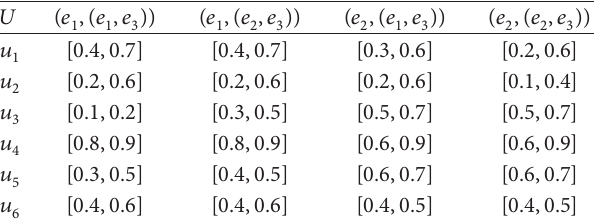
Table 7: Tabular representation of the IVF soft set L